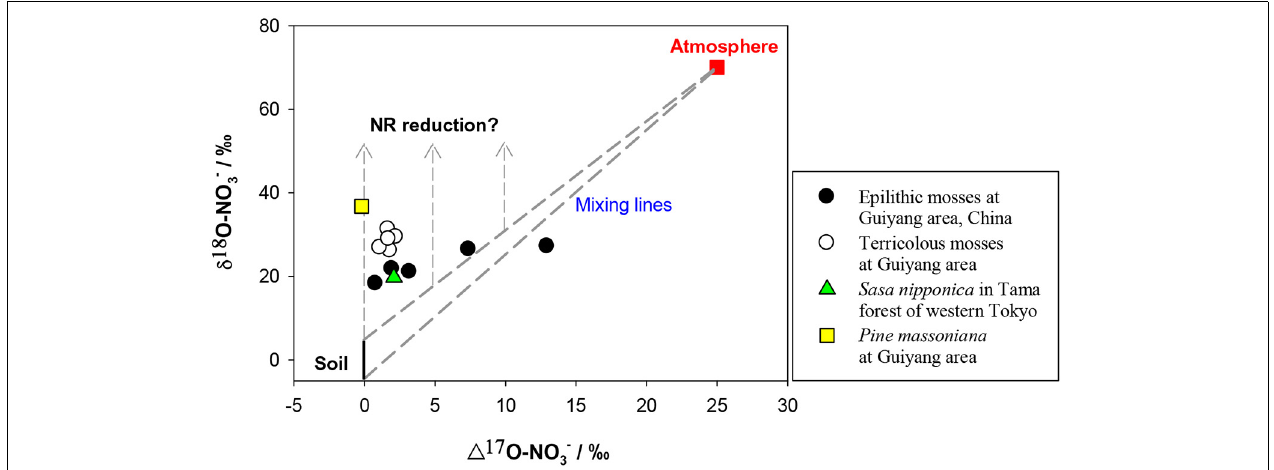
25 (cid:2) for atmospheric NO − 3 (red square). Dashed lines show the isotopic range of mixing between atmospheric and soil sources. Dashed lines with arrows show the vectors of δ 18 O enrichments because of NR